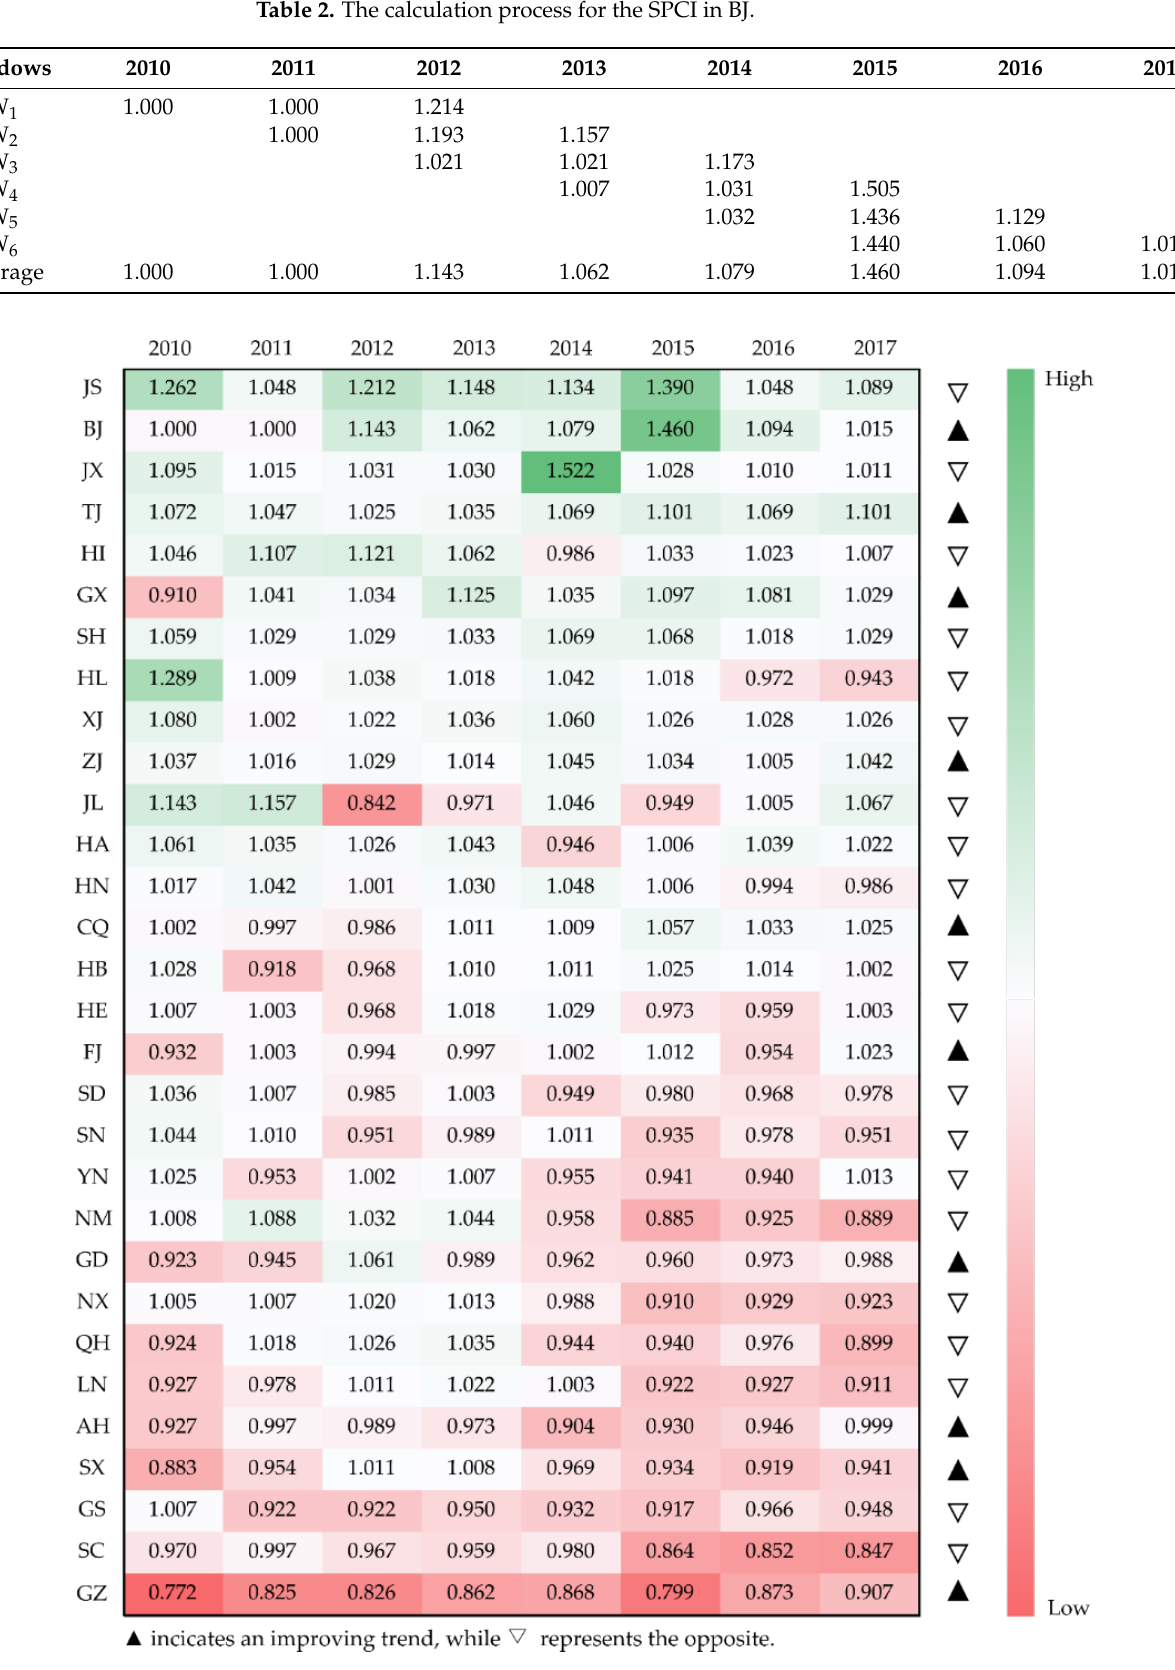
Figure 2. The scores for the SPCI in 30 provinces between 2010 and 2017. Figure 3 depicts the trend in the change in the eight regions’ scores for the SPCI. The scores for the SPCI in each region are the arithmetic mean of the scores of provinces in each region. The north coast and the Middle Yangtze River region can be characterized as having stable high scores for the SPCI. This is mainly because construction scale indicators (floor space of construction, total output value and total pretax profit) of the Middle Yang- tze River region are high and the local investment is large. Therefore, to maintain the stability or growth of SPCI, local governments need to obtain more desirable outputs under the condition of ensuring a certain input level. The south coast and southwest show similar patterns of improvement with overall low scores for the SPCI. The assessment re- sults for the east coast, northwest, northeast and Middle Yellow River region are not op- timistic because of their decreasing trends in the scores for the SPCI. The reason for the